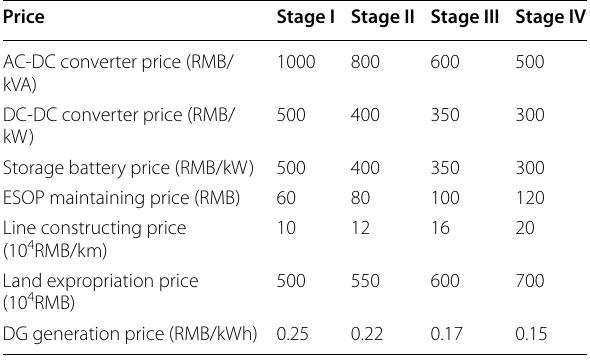
Table 1 Price parameters of various devices